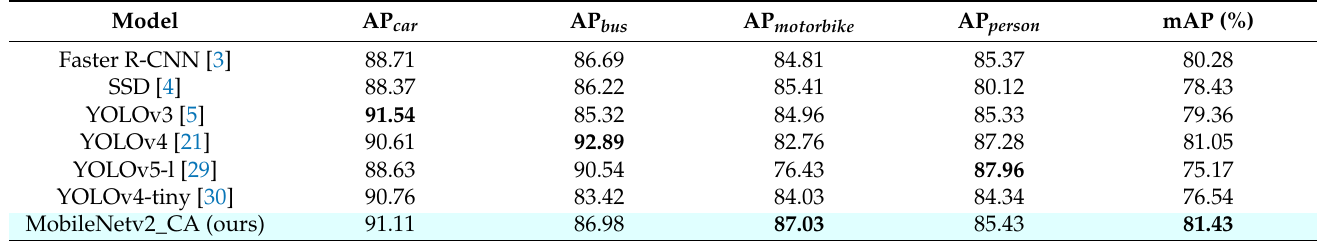
Table 6. Pascal Voc2007 + 2012 dataset detection performance.